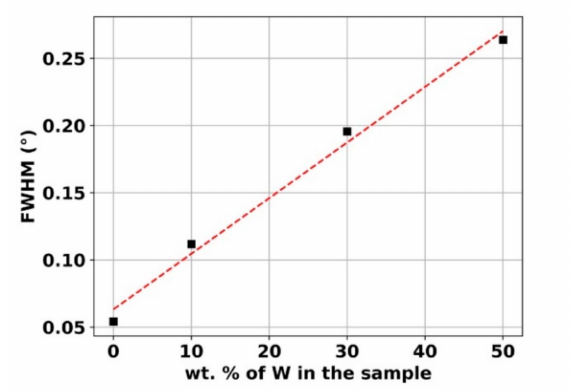
Figure 5. Evolution of the full width at half maximum (FWHM) of the Ni {111} or Ni(W) {111} as function of the weight percentage of W in the sample of the bulk Ni and Ni-W alloys in the unloaded